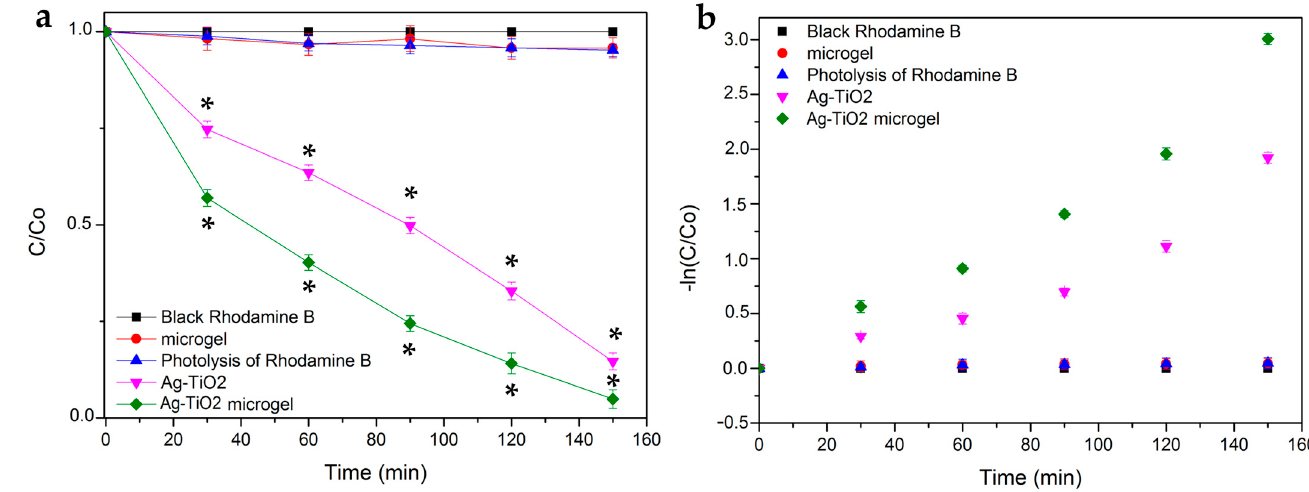
Figure 12. ( a ) Degradation curves of rhodamine B for Ag-TiO 2 , PNIPAM-co-PAA microgel and PNIPAM -co-PAA Ag-TiO 2 composite as a function of time, under visible-light irradiation. The phe- nomenon of rhodamine B photolysis and its degradation in the dark are also studied. The data rep- resent means ± standard deviation from three experiments. In these series of experiments, * p < 0.05 was considered statistically significant. ( b ) Photocatalytic kinetics of the degradation of rhodamine B for Ag-TiO 2 , PNIPAM-co-PAA microgel and PNIPAM-co-PAA Ag-TiO 2 , according to a linear pseudo-first-order model.